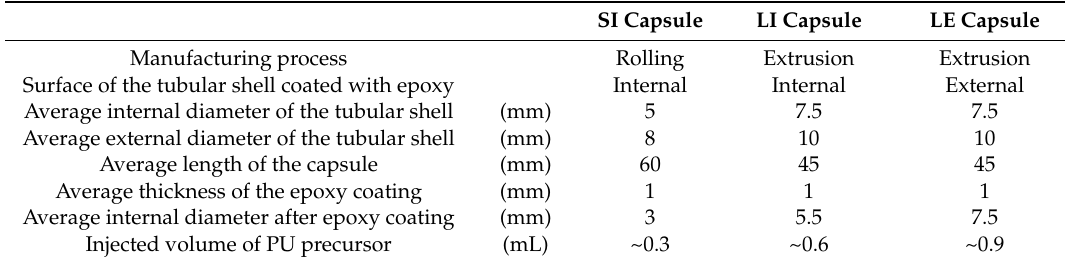
Table 2. Main characteristics of the different capsule series.